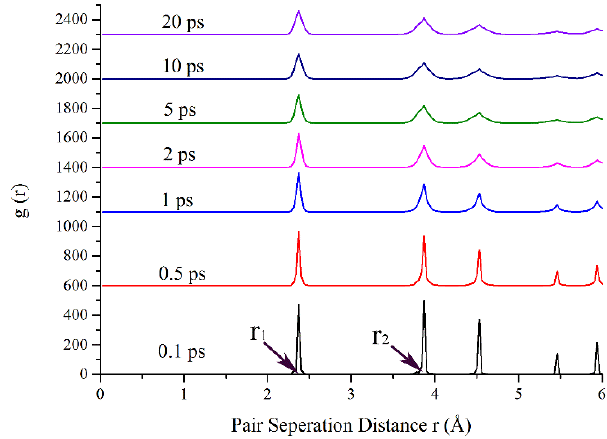
Figure 2. Radial distribution function of the silicon target during 0.5 keV Si 35 cluster implantation. r 1 is the first neighbor distance, and r 2 is the second neighbor